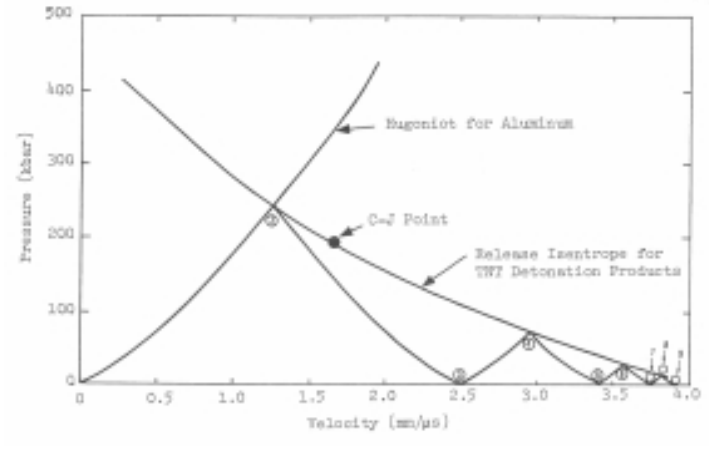
Fig. 2. Pressure versus particle velocity for aluminum flyer plate explosively loaded by